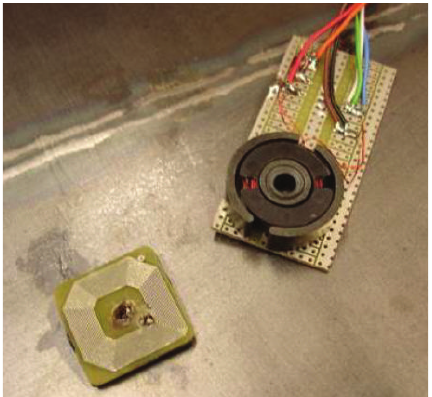
Figure 33: A prototype planar transducer based on the design in Figure 32 (lower left) and a pulse generation and detection probe (upper right). The PZT was 1 mm thick and 25 mm square, and the ferrite sheet was 1mm in thickness and 26 mm square [27].